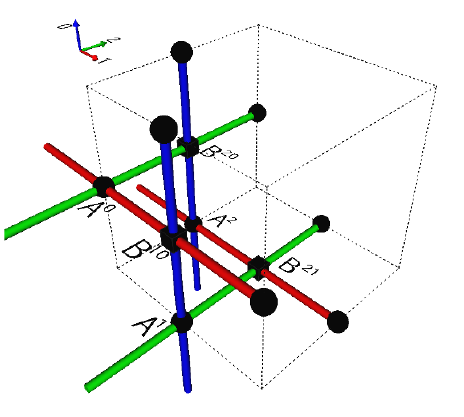
Figure 1 . Tensor network for Eq . (2.7). Dotted lines describe the cubic lattice. Black cubes and spheres represent B and A , respectively. Red, blue and green bars denote the contractions of the tensor